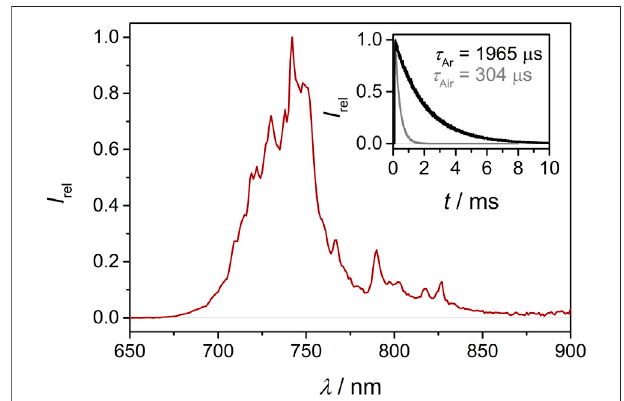
FIGURE1| Emissionspectrumof [Cr(tpe) 2 ][BF 4 ] 3 (1 mM)inacetonitrile after excitation at 355 nm. Inset: emission decay curves under deaerated (black) and aerated (gray)